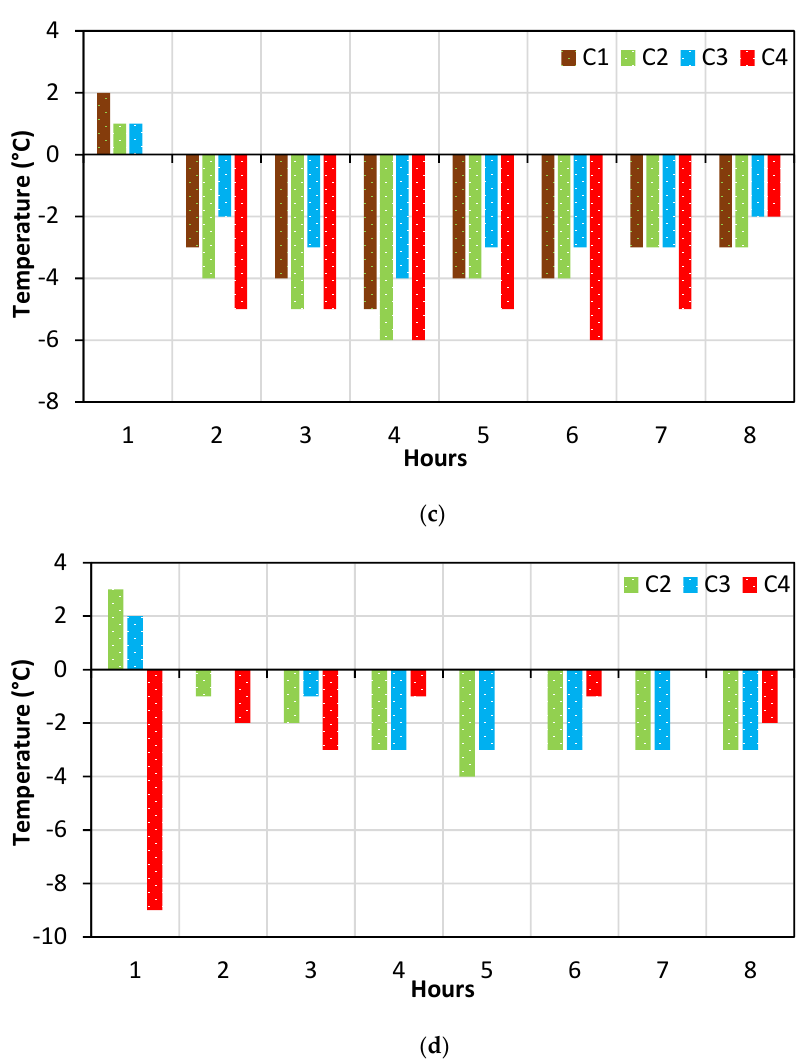
Figure 20. The rate of temperature fall in the specimens every hour at the ( a ) top, ( b ) middle, ( c ) bottom, and ( d ) cone.